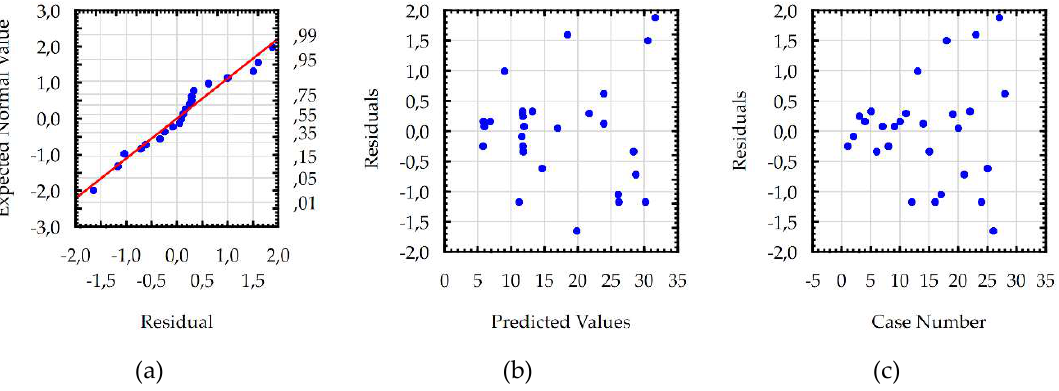
Figure 12. The plots to check the model for maximal white layer thickness: ( a ) the normal plot of residuals; ( b ) the residuals versus the predicted values; and ( c ) the residuals versus the case values.